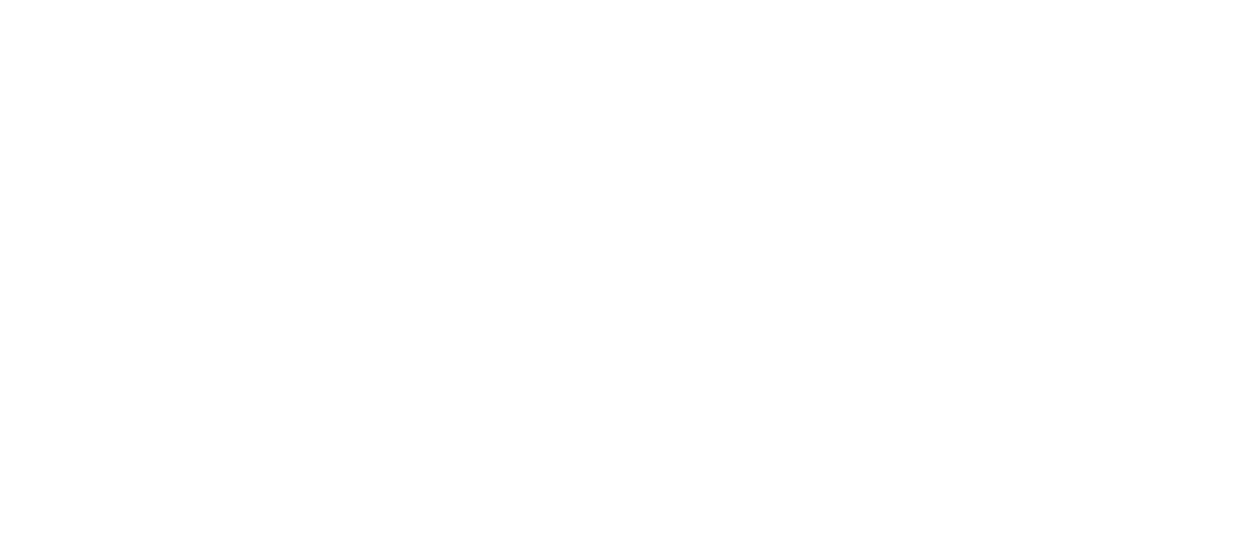
Figure A1 | Comparison between the orientation of DCX + fascicles and internal capsule fiber bundles. In (A) MIP along the y -axis of the 20 × reconstruction as shown in Figure 4C . In (B,C) lateral and caudal views, respectively, of a rough 3D reconstruction of part of the internal capsule fiber bundles (stained with MAG) running through the LS. The reconstruction has been obtained from 15 subsequent 40 μm thick sections and has been rendered in